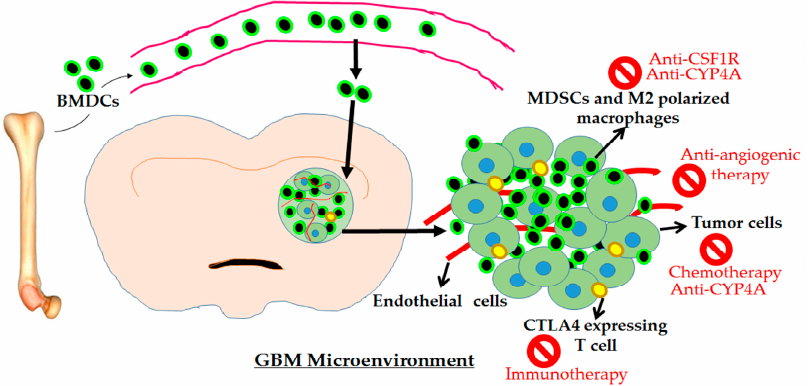
Figure 1. Schematic representation of GBM tumor microenvironment. Bone marrow-derived cells (BMDCs) are recruited to the tumor during the GBM growth. Recent data suggest that BMDCs recruitment was enhanced following therapies, e.g., anti-tumor chemotherapy or antiangiogenic therapy. The tumor-promoting myeloid cells are the subpopulations of recruited BMDCs in the microenvironment. Here, we propose the combination of anti-CSF1R, anti-CYP4A, or immune therapy with standard therapies to overcome the myeloid cell-mediated resistance in GBM.